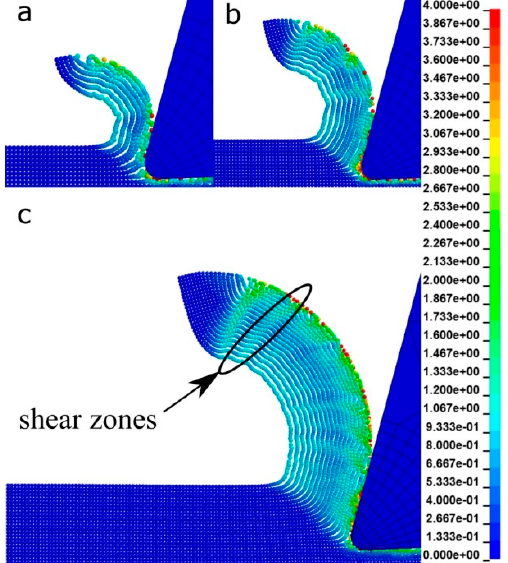
Figure 6. Equivalent plastic strain ε eq contours for a depth of cut h c : ( a ) 0.04 mm; ( b ) 0.06 mm; ( c ) 0.1 mm.